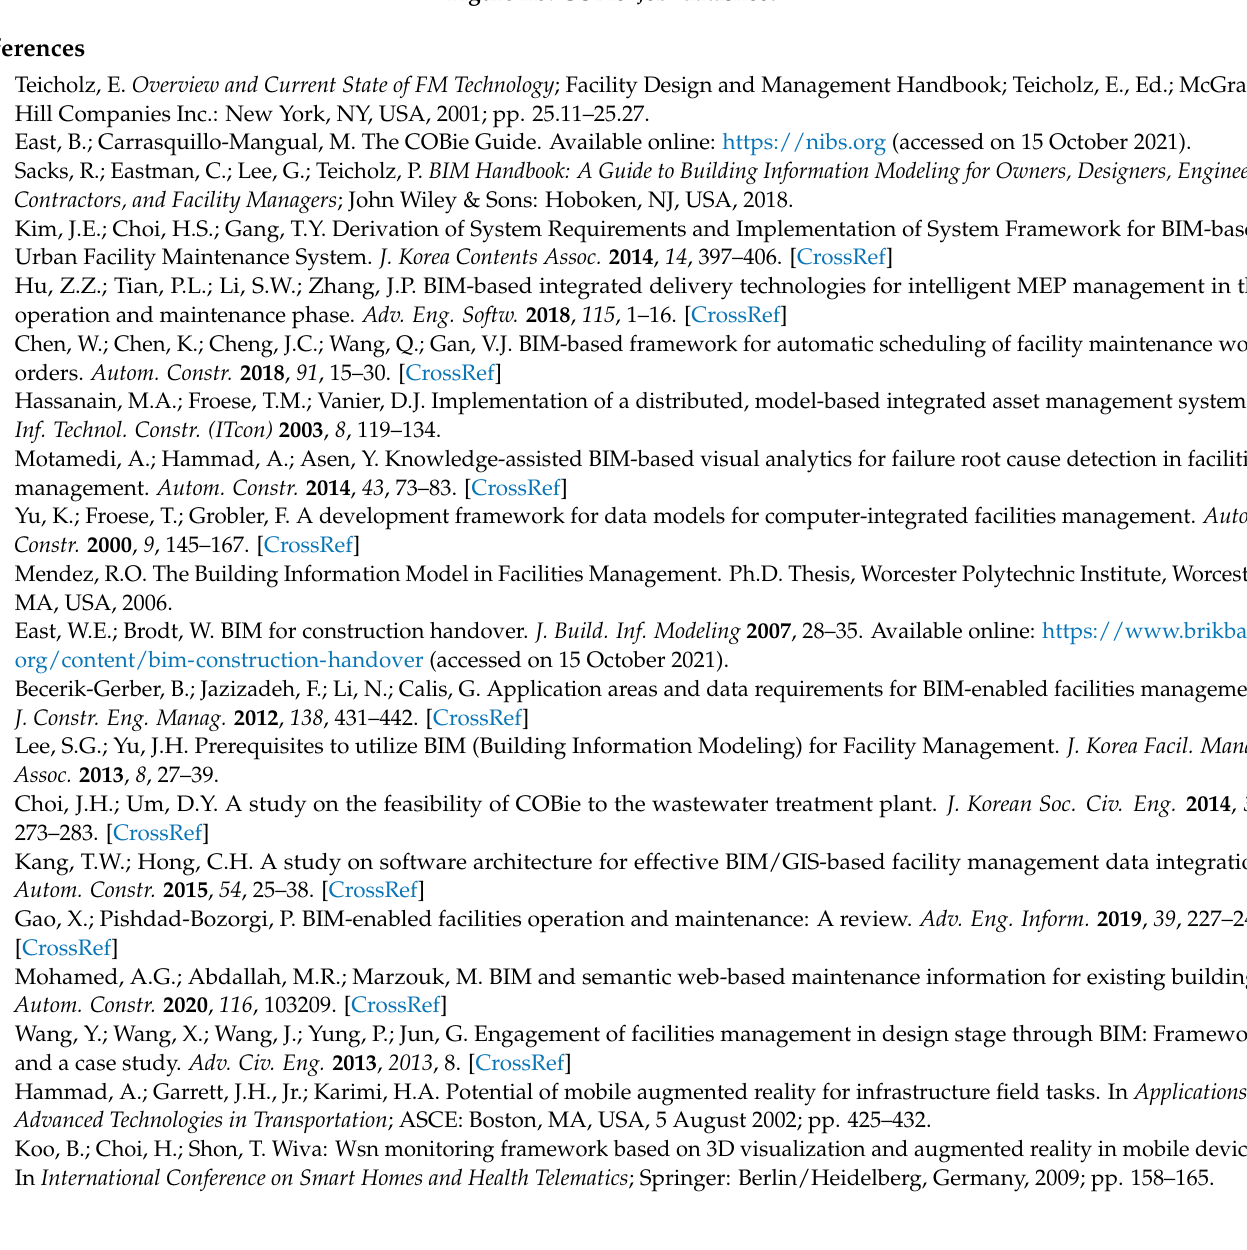
Figure A5 . COBie ‘Job’ datasheet. Figure A5. COBie ‘Job’